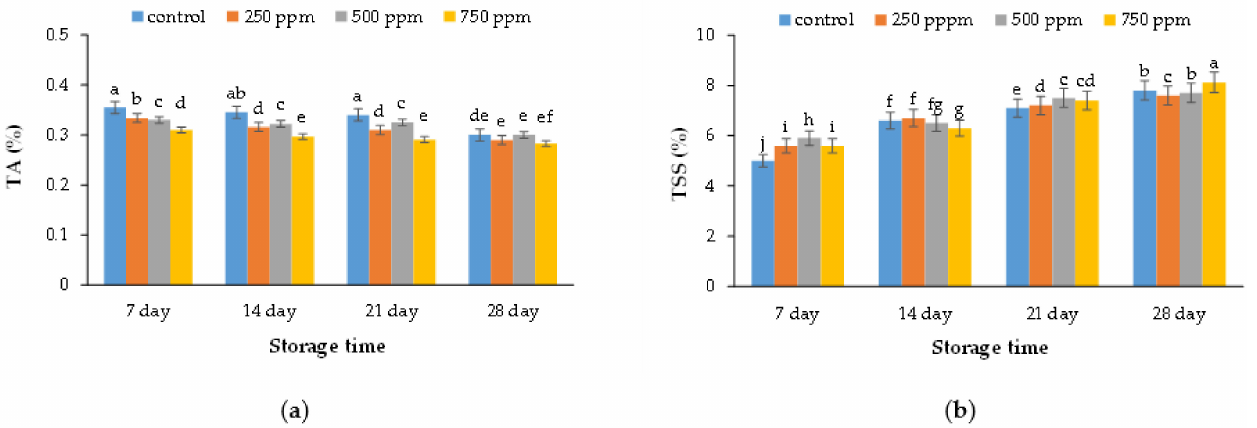
Figure 2. Effect of ACEOs on the quality attributes TA ( a ) and TSS ( b ) of strawberries during storage. Different letters indicate a significant difference ( p < 0.01) between